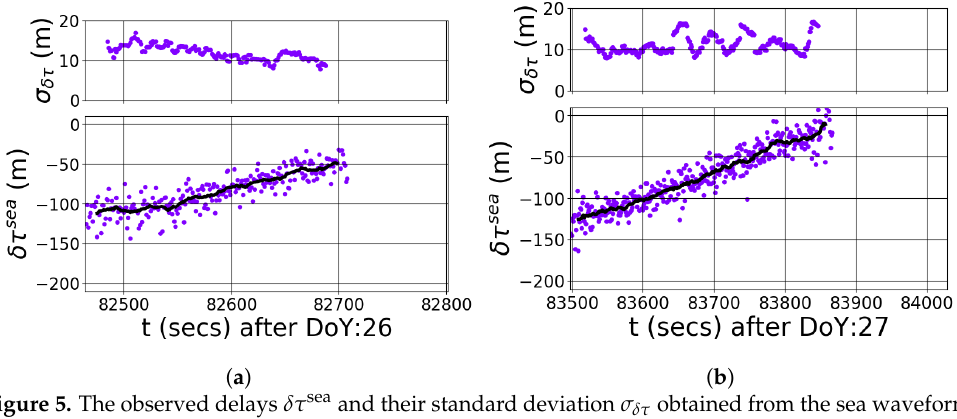
Figure 5. The observed delays δτ sea and their standard deviation σ δτ obtained from the sea waveforms. Superimposed on the values δτ sea we include a running mean used to derive σ δτ . The trend in the observed delays is attributed in this study to effects of TDS-1 clock inaccuracies. ( a ) 26 January 2015. ( b ) 27 January 2015.